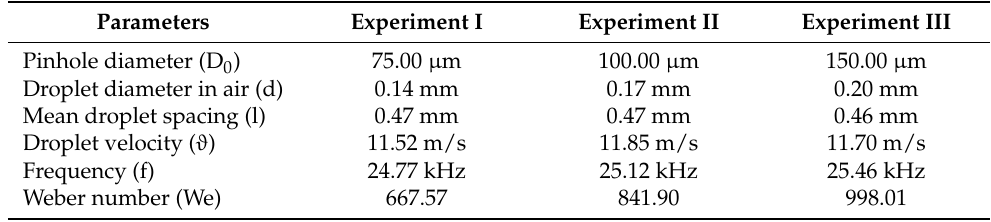
Table 1. Droplet train